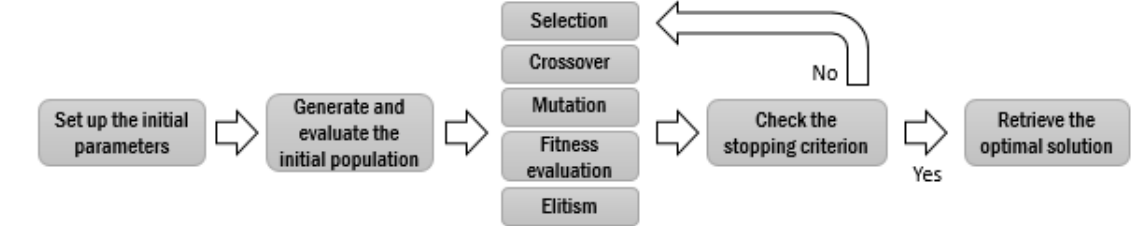
Figure 1. The basic genetic algorithm.